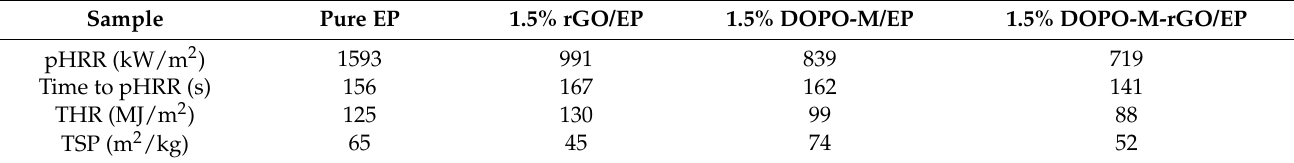
Figure 5. Digital photographs of the pure EP, rGO/EP composite, DOPO-M/EP composite, and DOPO-M-rGO/EP composite (the mass fractions of additive in the composites are all 1.5%) in the UL-94 test. Table 1. Cone calorimeter data of the neat EP and the EP-based